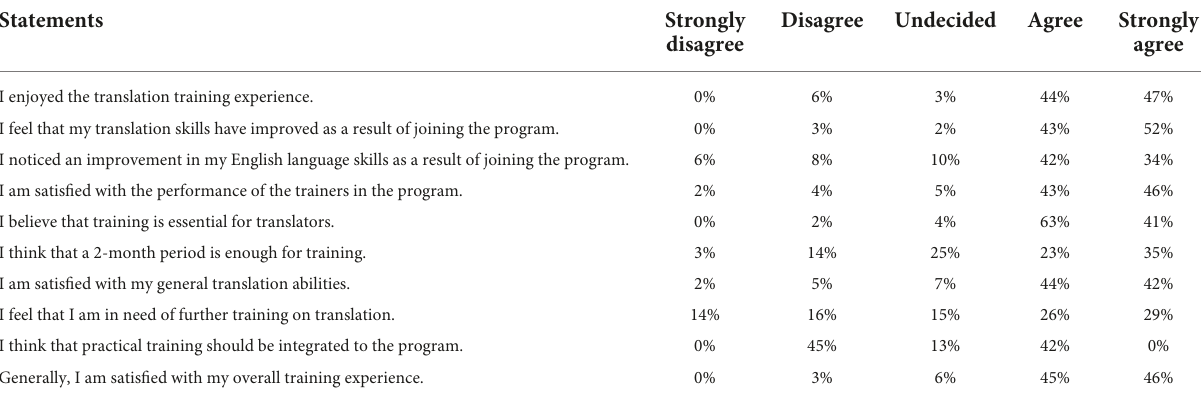
TABLE 5 Statistics of the questionnaire